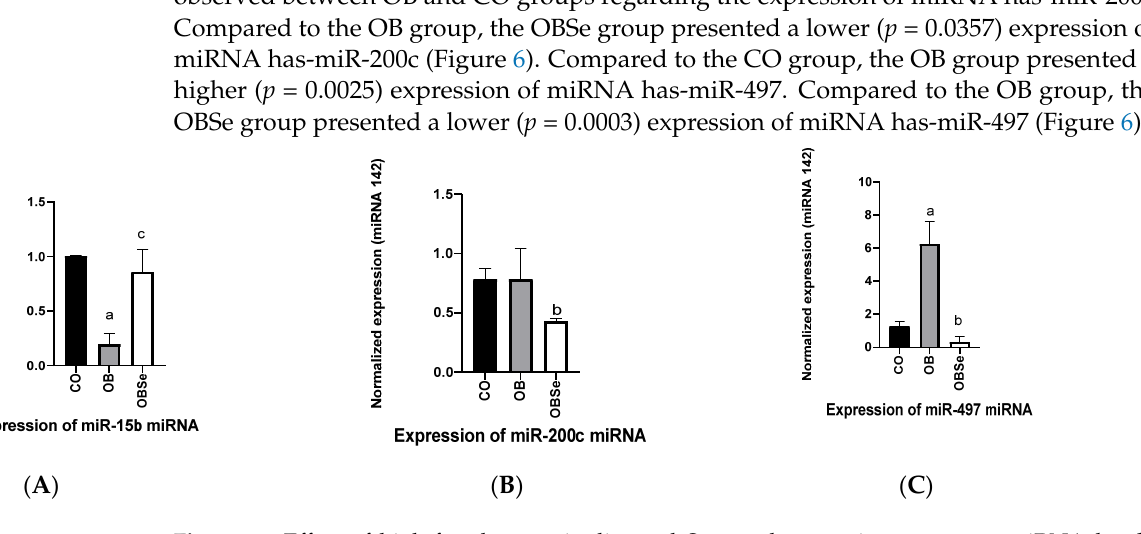
( I ) Figure 5. Effect of high-fat obesogenic diet and Se supplementation on gene expression in epididy-